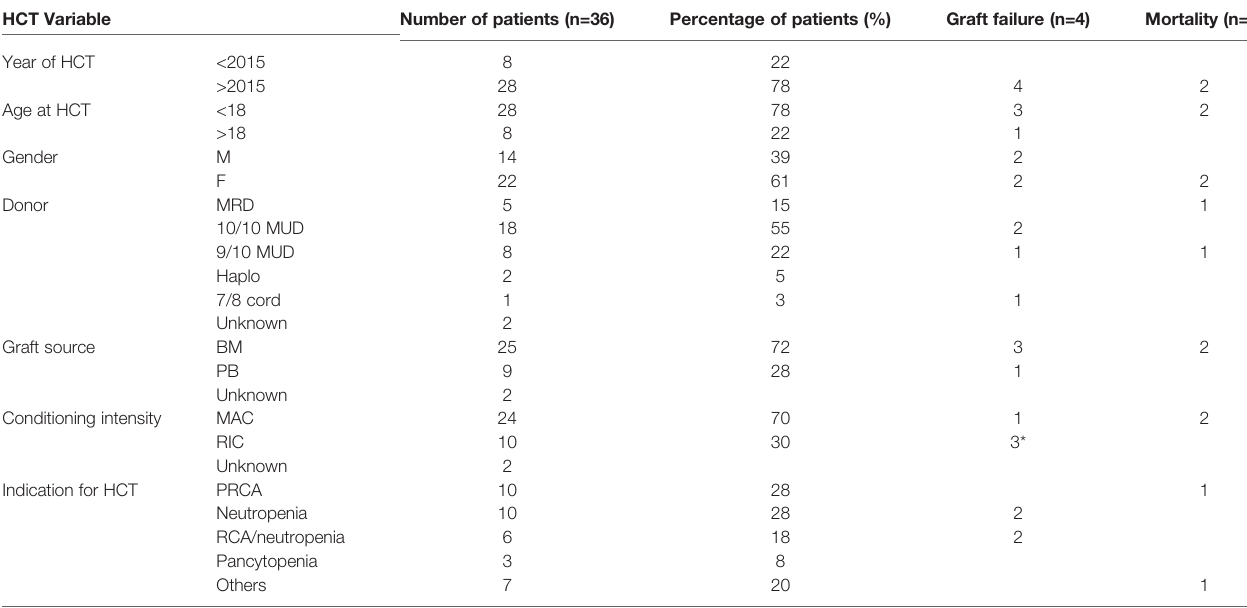
TABLE 1 | HCT characteristics and outcomes for published DADA2 patients